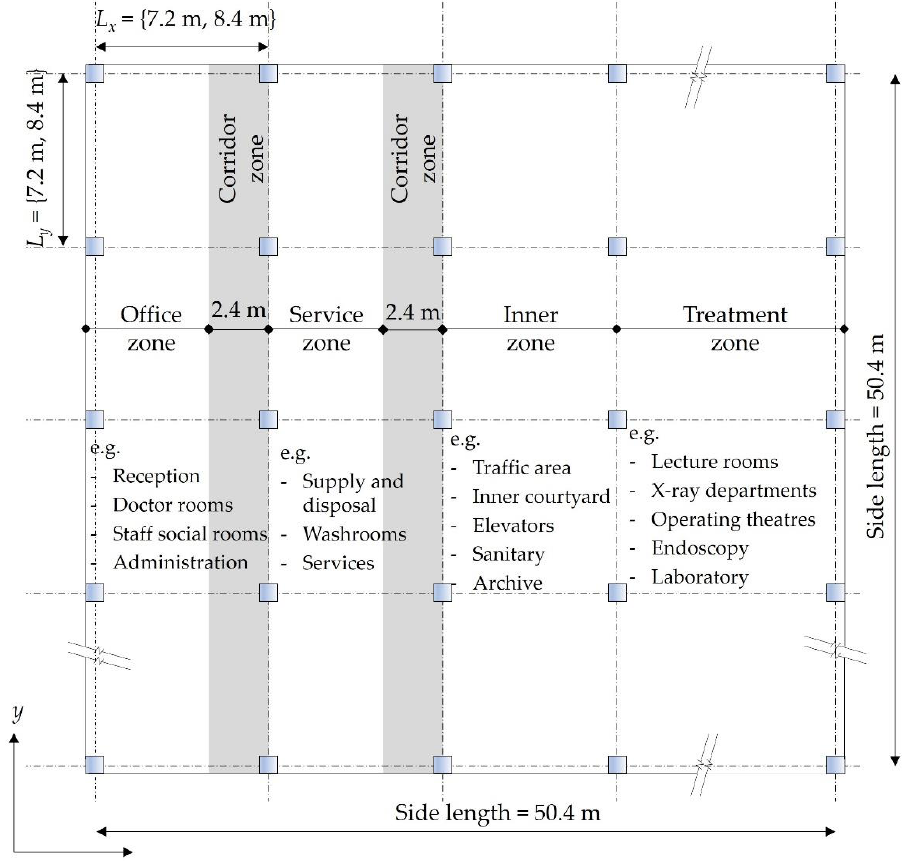
Figure 2. Hospital building’s plan layout scheme.